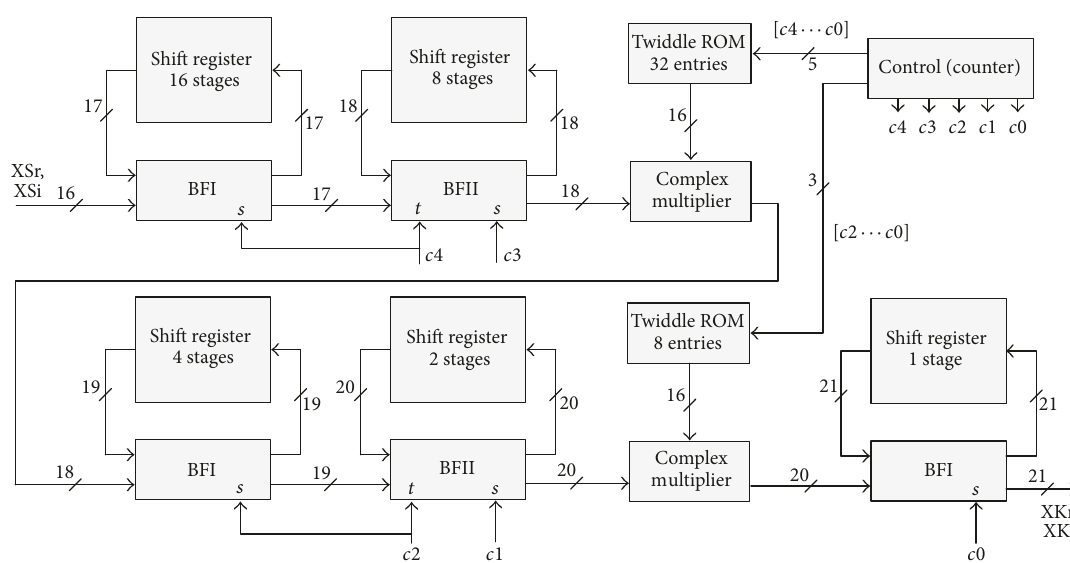
Figure 7: 32-point FFT structure using Radix-2 2 Single-Path Delay Feedback